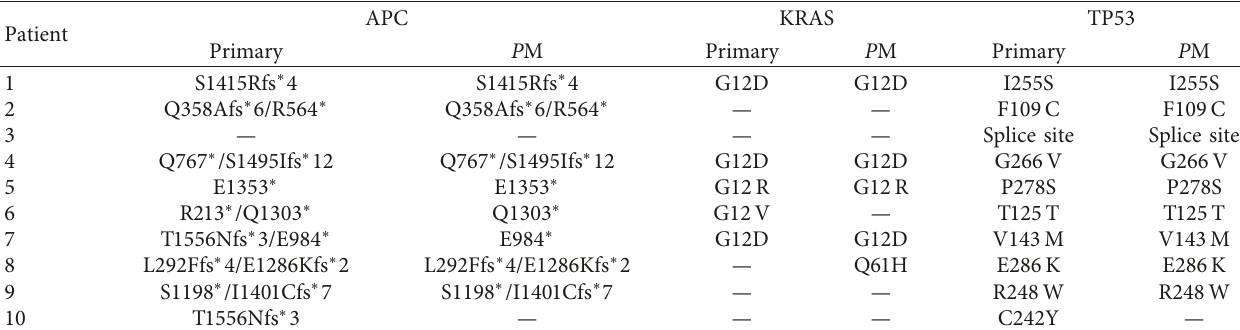
Table 2: Comparison of APC/KRAS/TP53 mutations in primary tumors and pulmonary